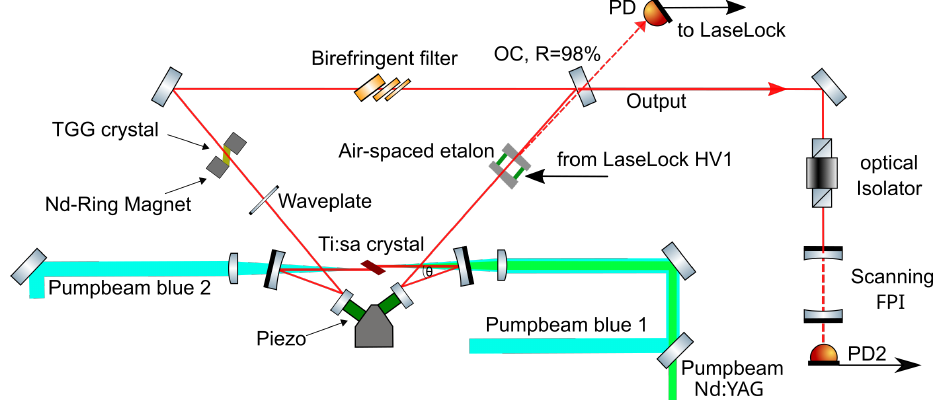
Figure 1. Optical layout of the laser